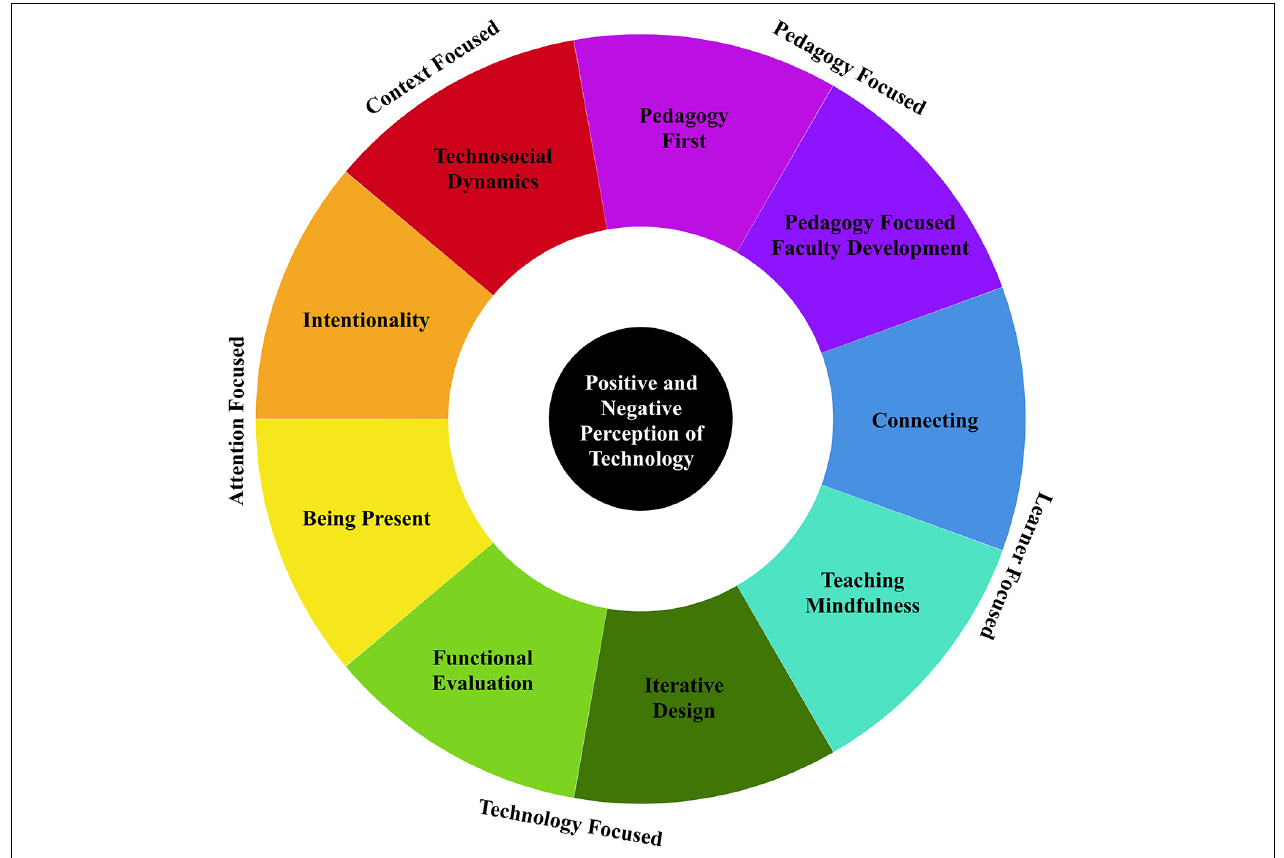
FIGURE 5 | Contemplative technopedagogy framework generated from discourse analysis of The Chronicle of Higher Education , 1993–2016.